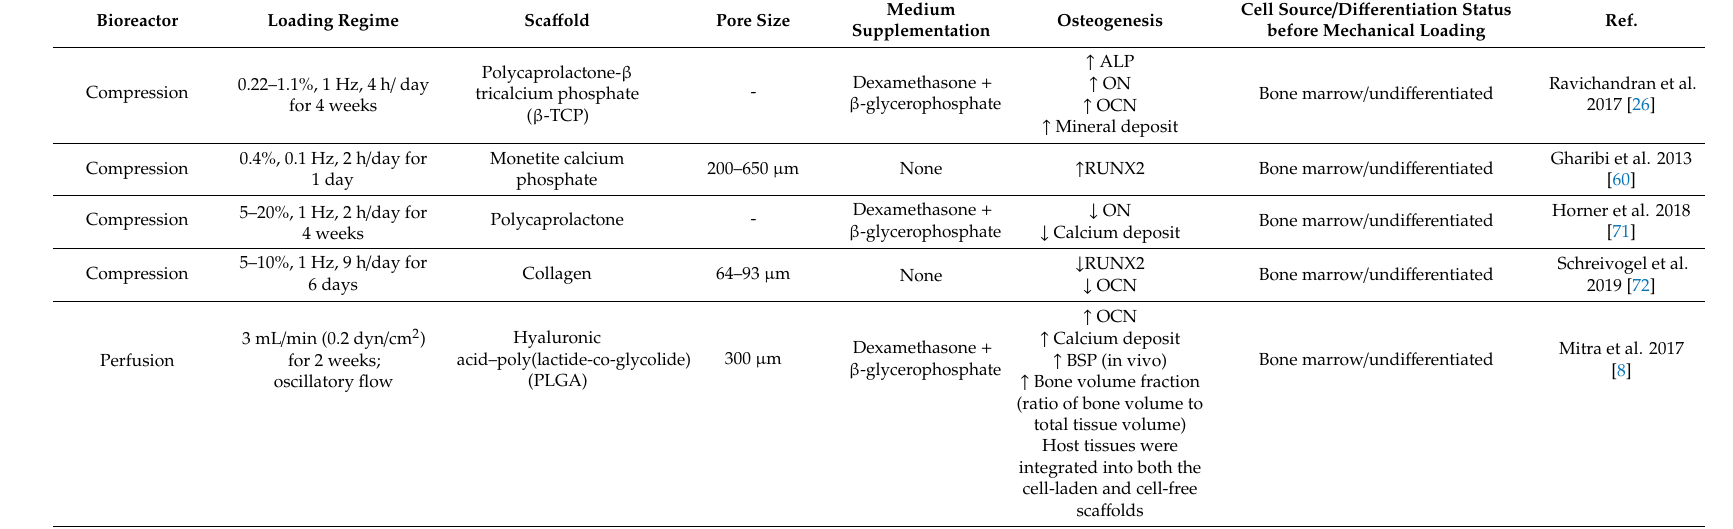
Table 2. Summary of the recent studies on the e ff ects of mechanical loading on hMSCs in a 3D sca ff